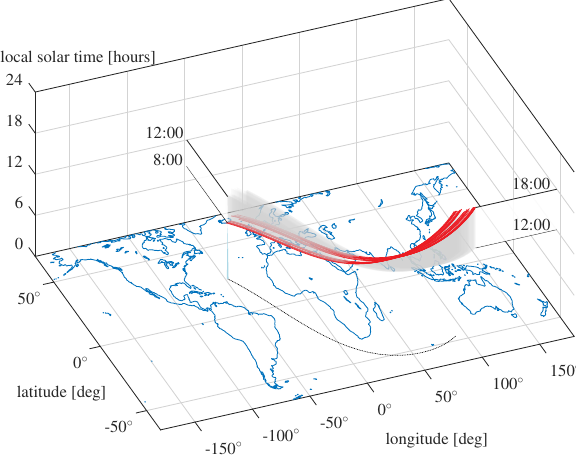
Figure 2. The spatial-temporal fly-through of one Planet flock in ISS-orbit. The paths are in respect to local-time as the flock flies through a nominal day on